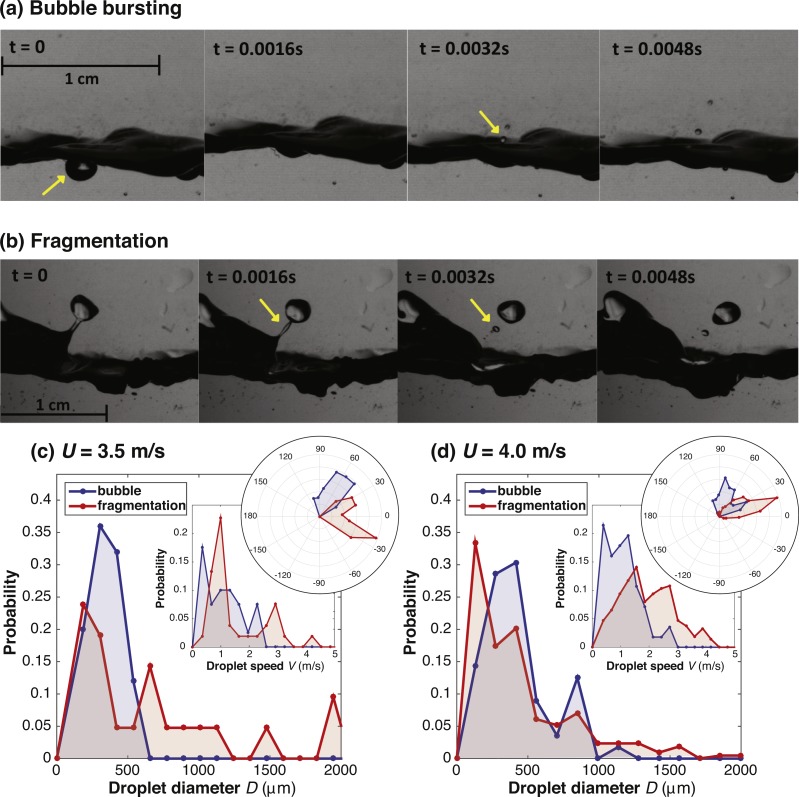
High speed images recorded at 6,250 fps.Series of high speed images recorded at 6,250 fps (i.e., 0.00016 s between frames) showing (A) bubble bursting droplet formation and (B) fragmentation droplet formation. The wind direction is to the right. Each series shows four images 10 frames apart. The sub-surface bubble in the first frame of (A) produces droplets seen in the third frame. The ligament identified in the second frame of (B) breaks up into droplets. See the video version at the following URL: https://youtu.be/lGZmx4h0yMA. (C–D) Probability distributions for droplet diameter (D), droplet ejection speed (V), and ejection angle at wind speeds U = 3.5 and 4.0 m/s (measured at 2.5 cm above water surface) for bubble bursting droplets (blue) and fragmentation droplets (red). The downwind direction is zero degrees and the radial increments are 0.05 on a relative scale. For 3.5 m/s, bubble and fragmentation droplets have population sizes n = 26 and n = 33, respectively. For 4.0 m/s, the population numbers are n = 57 and n = 221, respectively.